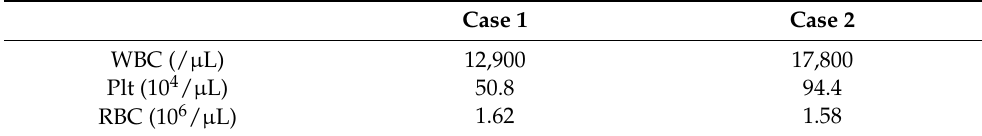
Figure 1. PRP preparation and procedure. ( A ) Using the GPS III system (Zimmer Biomet), 3 mL of PRP was collected from anticoagulated blood after centrifugation. ( B ) Under local anesthesia and fluoroscopy, 2 mL of PRP was administered into the disc with a discography needle. Table 2. LR-PRP